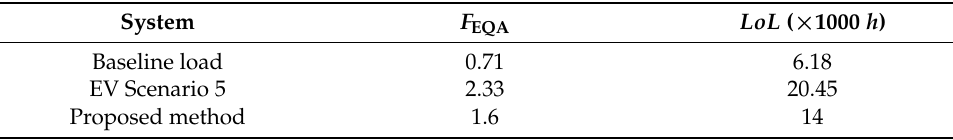
Figure 16. Transformer’s annual ( a ) equivalent aging factor, F EQA ; and ( b ) loss of life, LoL . Table 10. Annual F EQA and LoL in scenario 5 (40 % EV penetration).